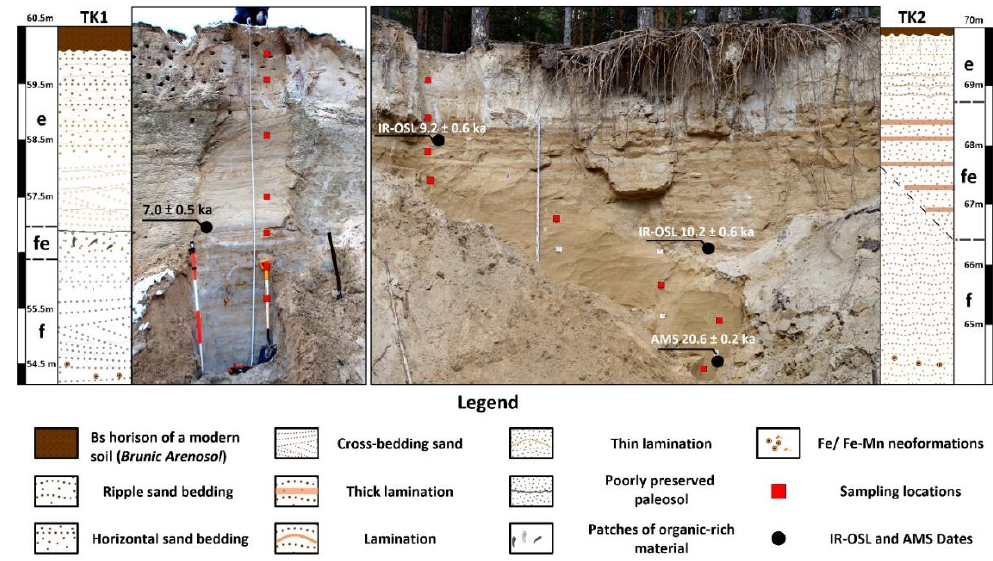
Figure 3. Lithological scheme of studied sections. Units: e—aeolian unit; fe—fluvio-aeolian unit; f—fluvial unit.